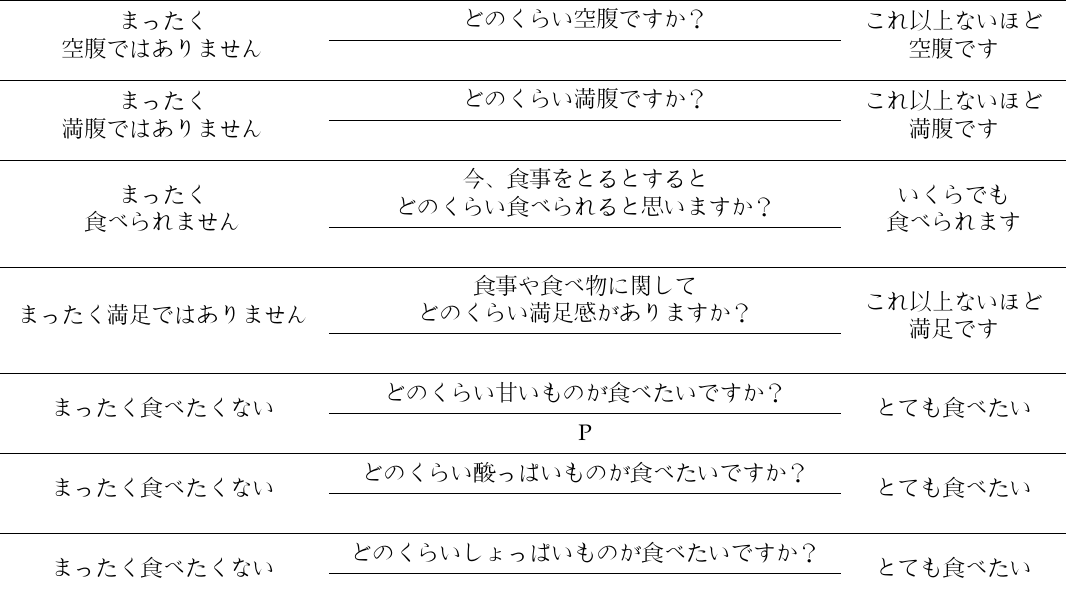
Table A4. Questionnaire with ratings of appetite, satisfaction and desire for specific tastes (Japanese